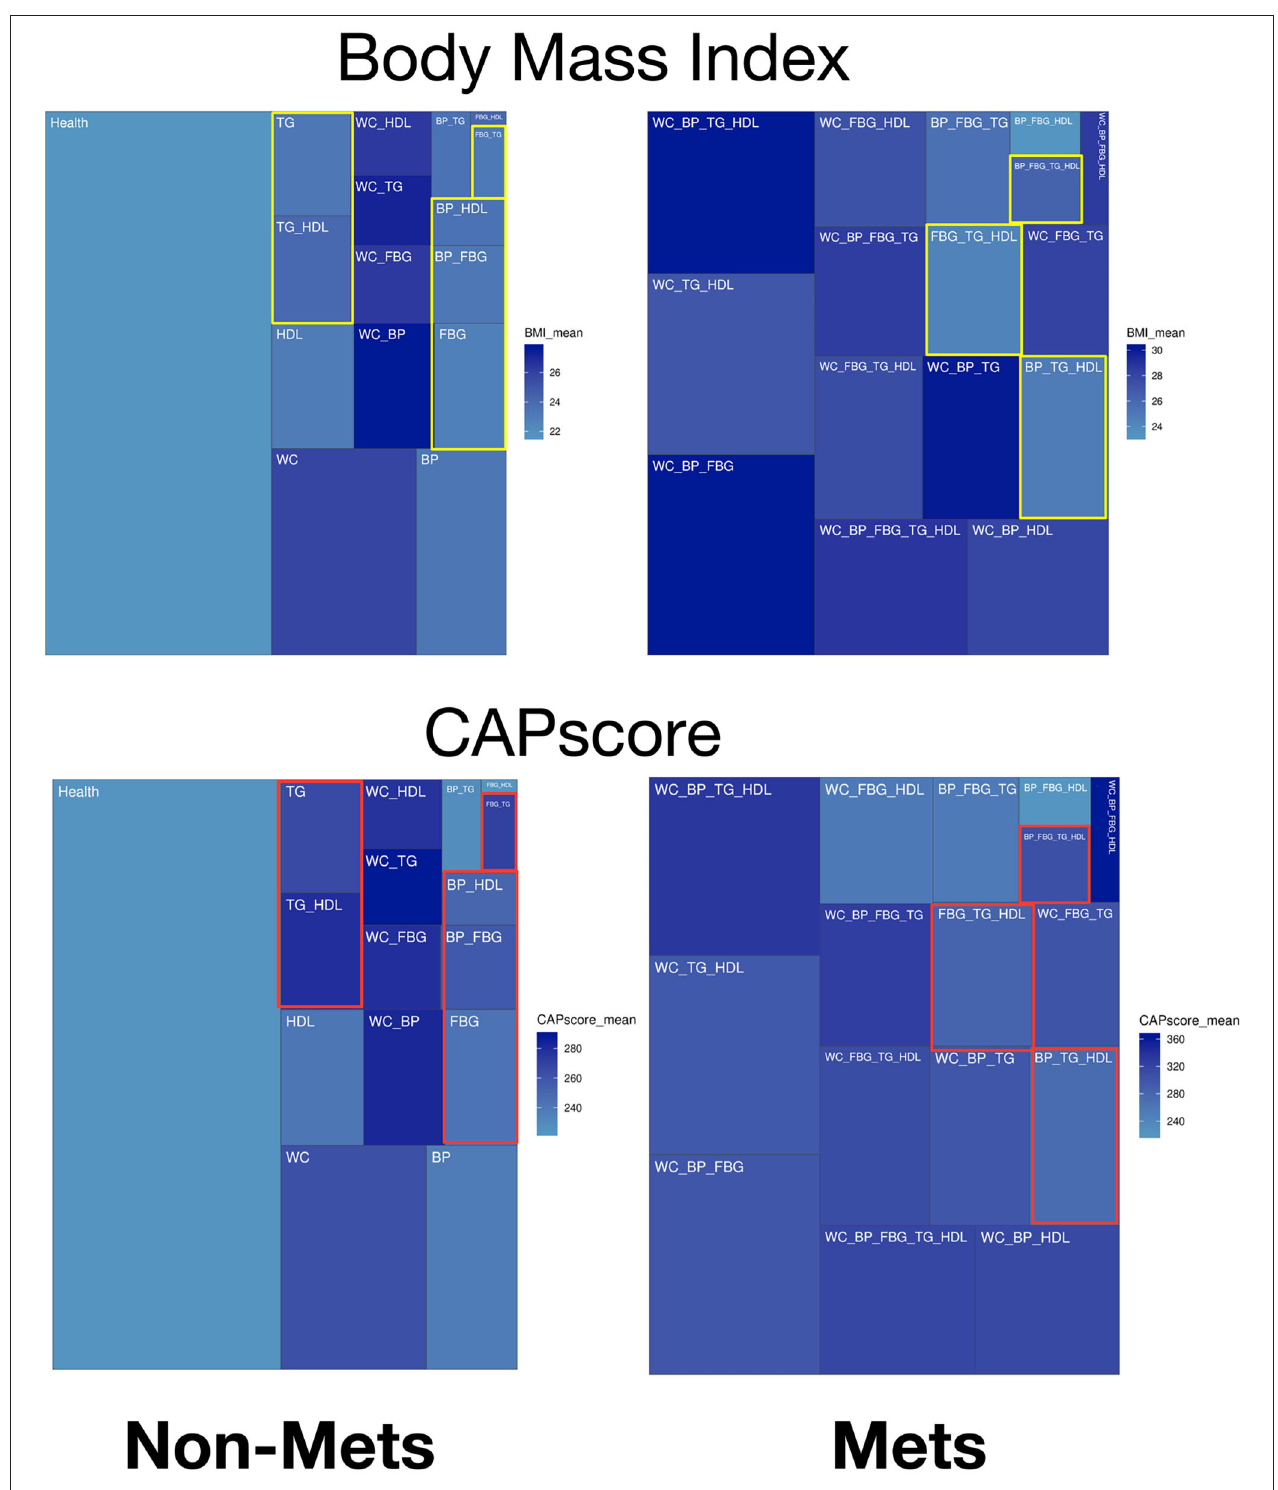
FIGURE 2 | Treemaps of significant predictors within different combinations of metabolic components for non-MetS and MetS subjects. Body mass index (BMI) is the upper panel and CAP score is the lower panel.